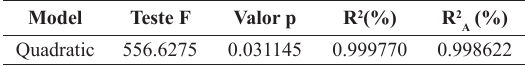
Table 6. Analysis of variance (ANOVA) from quadratic